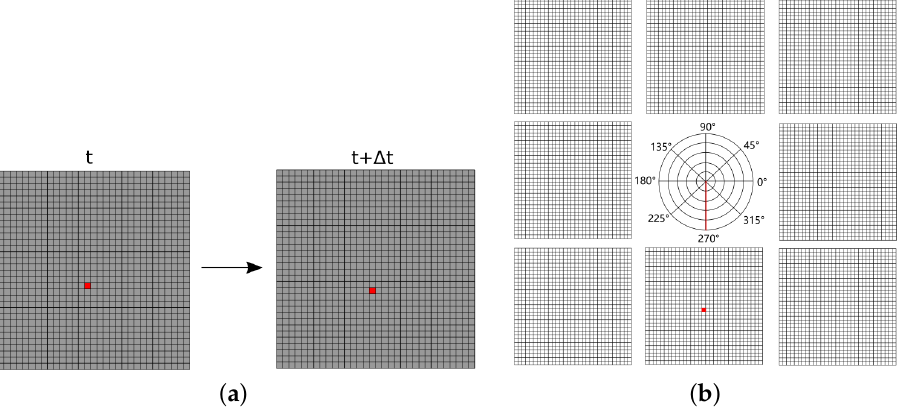
Figure 9. ( a ) In the first accuracy experiment, the position of the object in its initial state and the position of the object after moving down one pixel. ( b ) In the first accuracy experiment, the scanned image obtained by GDDN, which shows that only the LDDN corresponding to the downward direction is